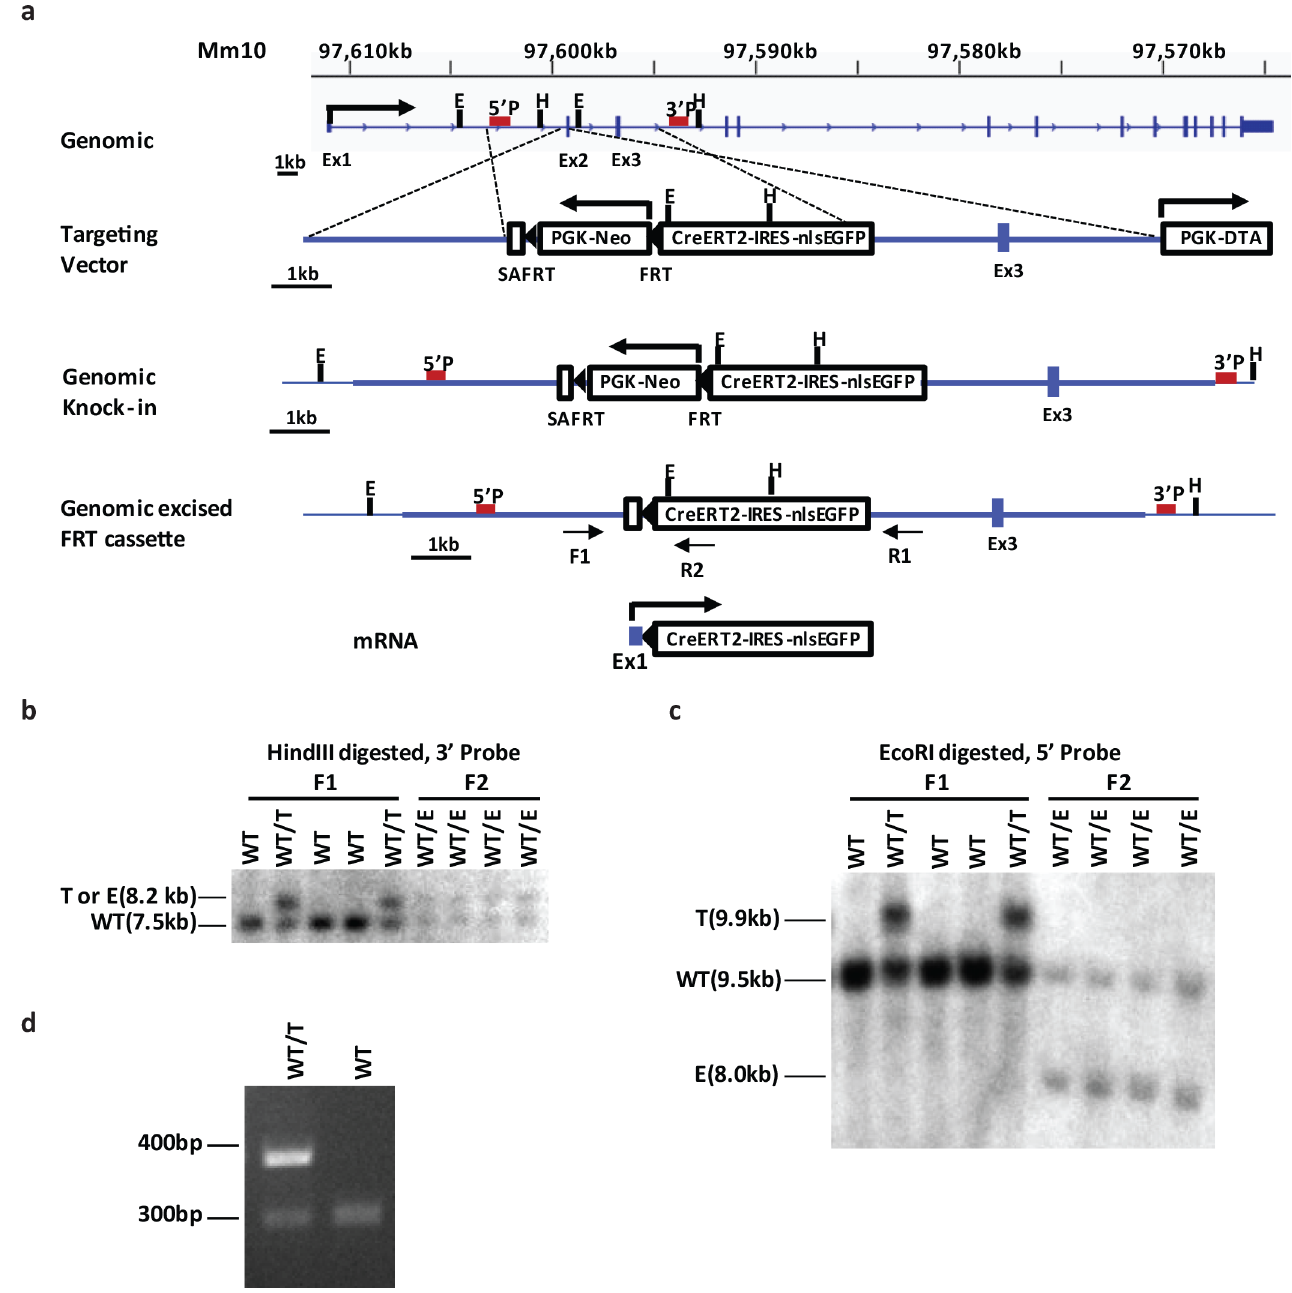
Fig 1. Generation of the Tmprss2-CreER T2 knock-in mouse. (a) Schematic of targeting strategy. A cassette including an adenovirus splice acceptor (SA), followed by PGK-driven neomycin selection cassette flanked by FRT recombination sites, followed by the CreER T2 -IRES-nlsEGFP was used to replace exon 2 of mouse Tmprss2. The cassette is flanked by 3.5kb 5 ’ and 5kb 3 ’ homology arms. 5 ’ and 3 ’ Southern probes as was as HindIII (H) and EcoRI (E) sites and genotyping PCR primers (universal F1, wild-type specific R1, and knock-in specific R2) are depicted. The final transcript includes the non-coding exon 1 of Tmprss2 spliced into the CreER T2 -IRES-nlsEGFP gene. (b) Southern blot using 3 ’ probe and HindIII digestion. WT mice give a 7.5 kb band and the targeted mice (regardless of neomycin cassette) give a 8.2 kb band. (c) Southern blot using 5 ’ probe and EcoRI digestion. WT mice give a 9.5 kb band; the targeted mice with neomycin cassette (T) give a 9.9 kb band, while the mice with excised neomycin cassette (E) give a 9.5 kb band. (d) Genotype determination of wild-type and heterozygous mice by PCR. Wild-type fragment is 300-bp and mutant is